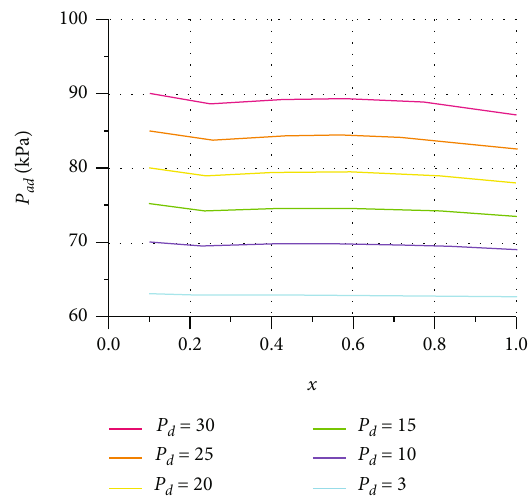
Figure 12: Relation between balance diaphragm pressure P ambient pressure P a at di ff erent di ff erential pressure P d ad and